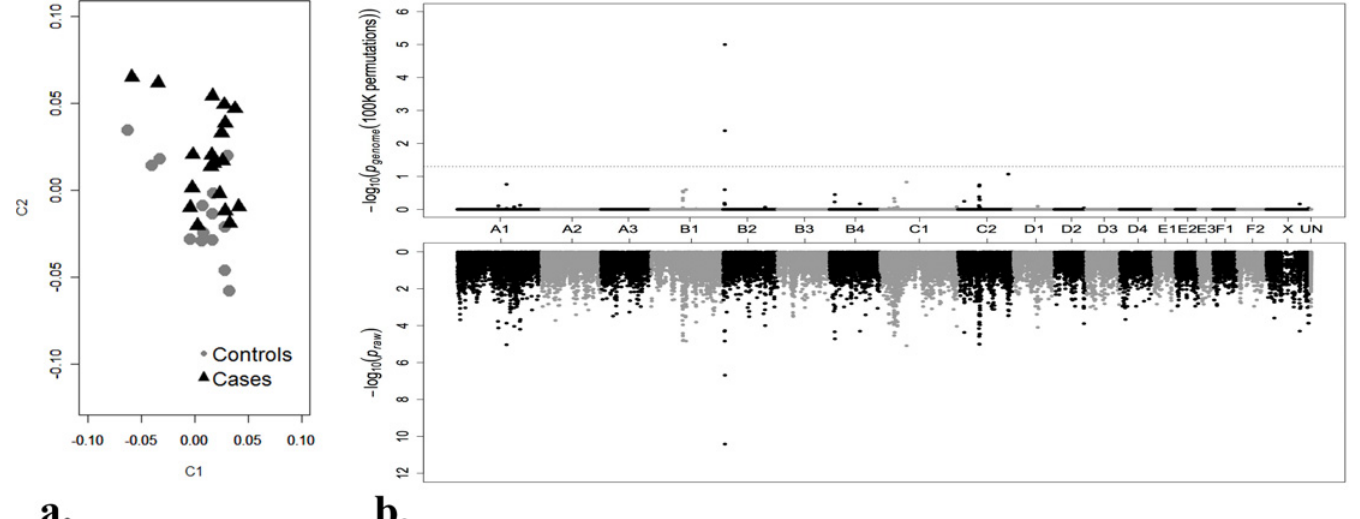
Fig 1. Multidimensional scaling and Manhattan plot summarizing the GWAS for Ragdoll cats with blood type AB. a. MDS showing the distribution of the Ragdoll cases and controls included in the analyses. Significant overlap of cases and controls suggests minimal substructuring in the dataset. b. The plot represents the P raw (top) and P genome (bottom) values of the SNPs included in the GWAS case – control analysis. The black dashed line (bottom) suggests the SNPs with genome-wide significance after permutation. Two SNPs on chromosome B2 (positions 4,487,432 and 4,449,822, respectively) remained significantly associated with the AB blood type phenotype.